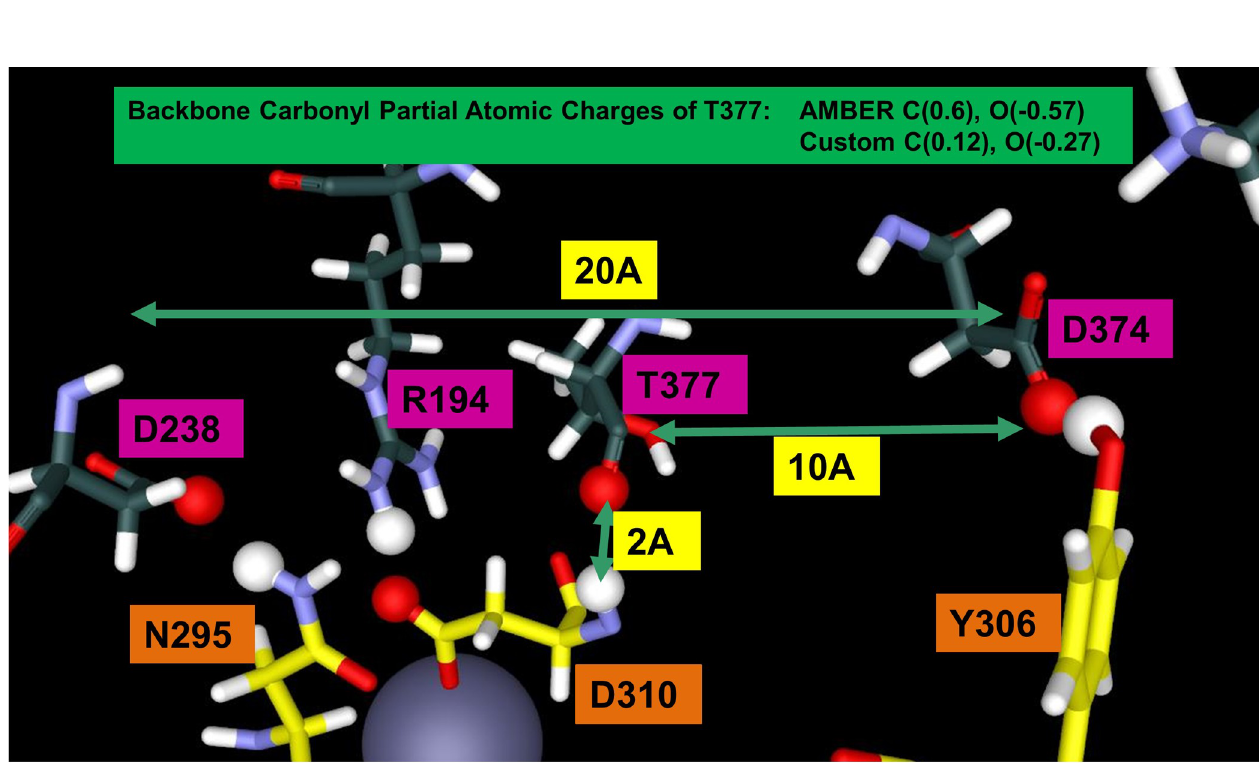
Fig 6. There is a dramatic change in polarization of the PCSK9 T377 backbone induced by LDLR binding. Standard partial charges from the Amber force field of a threonine carbonyl backbone are carbon (+0.60) and oxygen (-0.57). The GAMESS/RESP partial charges for the T377 of PCSK9 when interacting with LDLR-H306Y are carbon (0.12) and oxygen (-0.27), confirming that modeling indicates a profound and pervasive electron delocalization in this